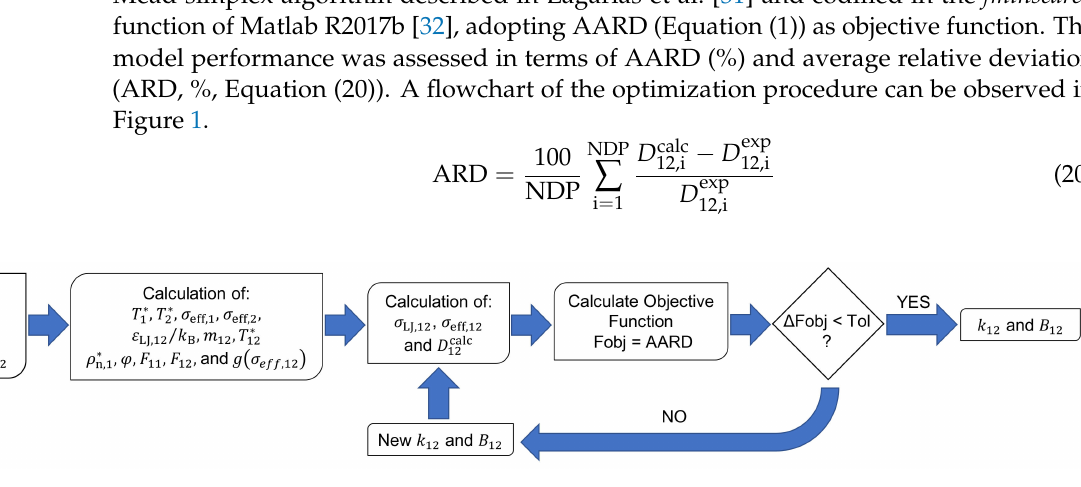
Figure 1. Schematic representation of the optimization process. The objective function is in this work the AARD (Equation